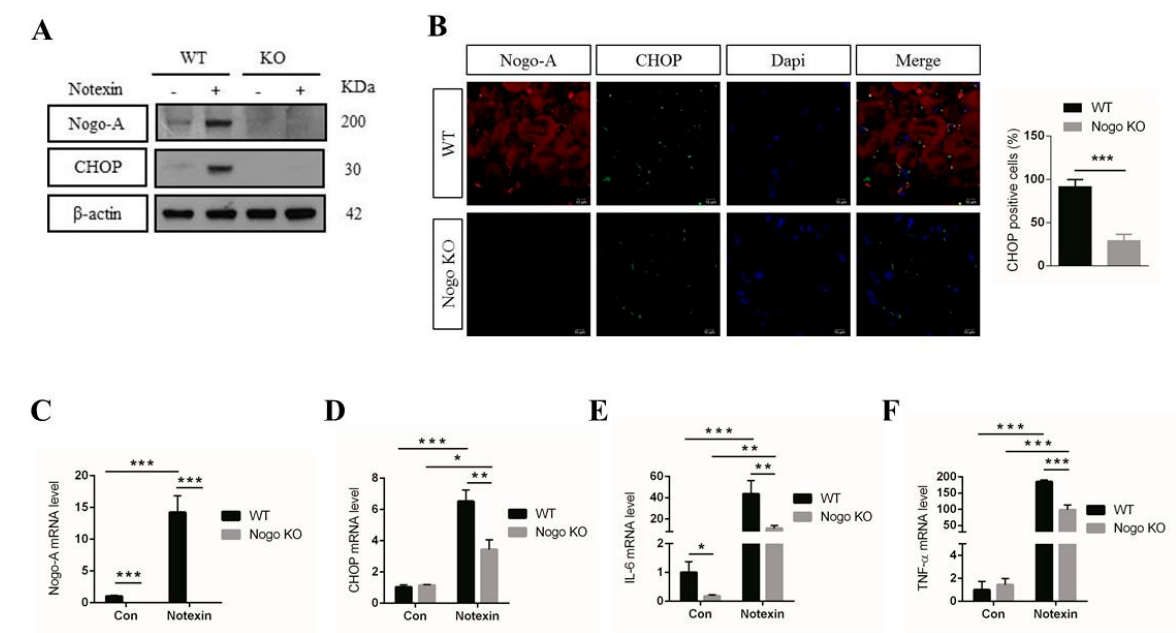
Figure 5. Pro-inflammatory factors mediated by CHOP signaling. ( A ) Nogo-A, CHOP, and β -actin protein expression levels in muscle from notexin-treated WT mice compared with muscle from notexin-treated Nogo-KO mice ( n = 3). ( B ) Expression of CHOP in injured muscle from WT mice compared with its expression in injured muscle from Nogo-KO mice ( n = 3) by immunofluorescence (IF). ( C – F ) Nogo-A, CHOP, IL-6, and TNF- α mRNA expression levels in gastrocnemius muscle isolated from WT ( n = 3) and Nogo-KO mice ( n = 3) 3 days after a single intramuscular injection of notexin (12.5 µ g/mL). Data were normalized to RNA expression of GAPDH. In all, 40 µ g of protein was used for immunoblot (IB) experiments. Data are shown as the mean ± standard error of the mean. Statistical significance was determined using Student’s t -test. Secondary antibodies used were Alexa Fluor (AF)-555 and AF-488. Significant data are denoted by asterisks where * p < 0.05, ** p < 0.01, and *** p < 0.001. Scale bar, 10 μ m, ×400 magnification.